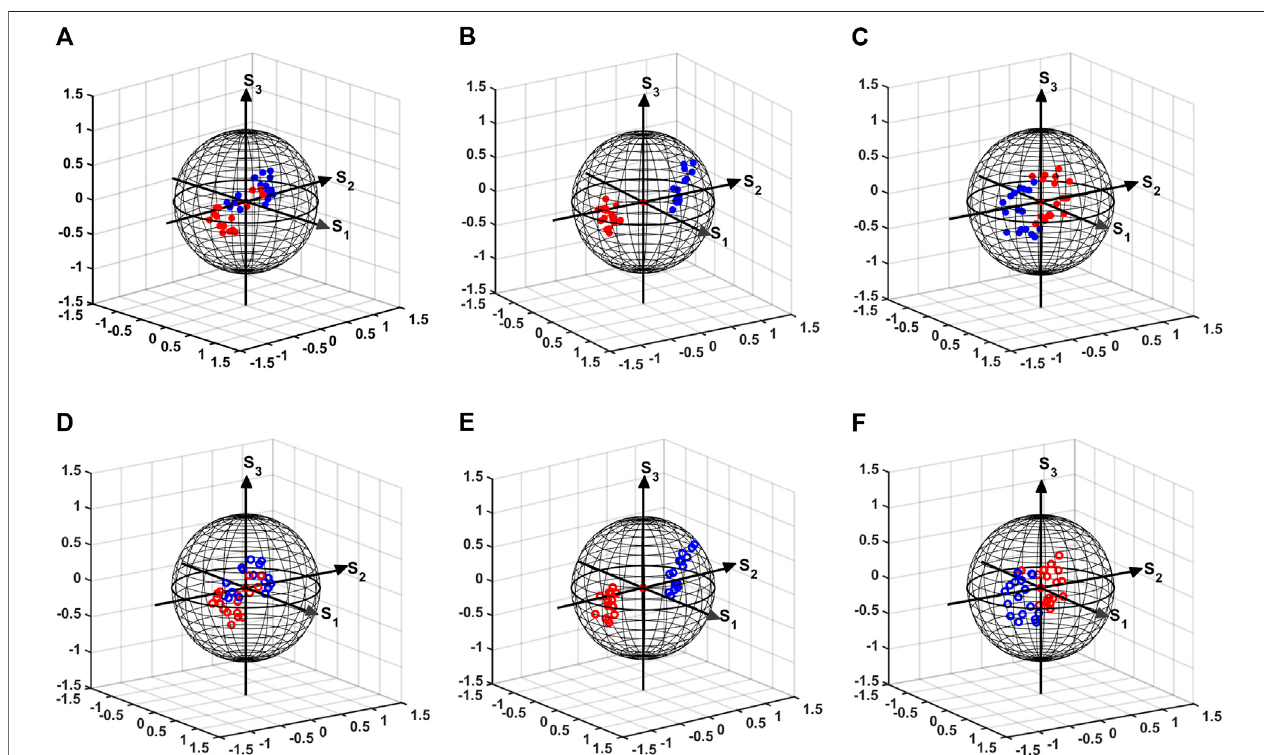
FIGURE 6 | Poincare sphere representation of SOP modulation at different gray values of SLM. (A – C) : SOP modulation trajectories at central part (D – F) : SOP modulation trajectories at the left edge of SLM display. Red dots represent SOP modulation corresponding at incident SOPs “ H-polarized, ” “ 45 ° polarized, ” and “ right circularly polarized ” light and blue dots represent the SOP modulation corresponding to incident SOPs “ vertically polarized, ” “ 135 ° polarized, ” and “ left circularly polarized ” light, respectively.